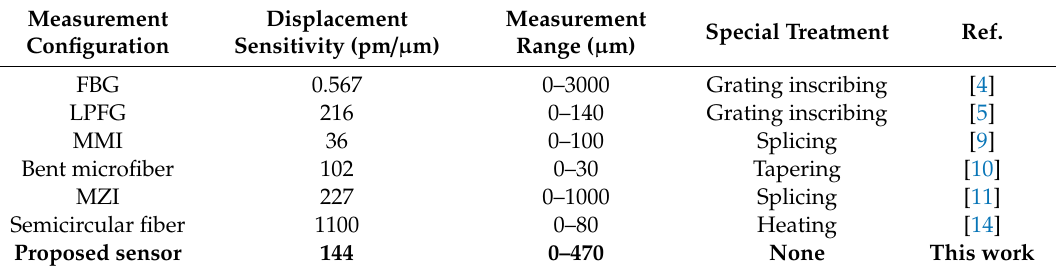
Figure 10. Spectrum variation as a function of displacement including displacement increase and decrease processes. Table 1. Comparison of the performance of different displacement sensors.